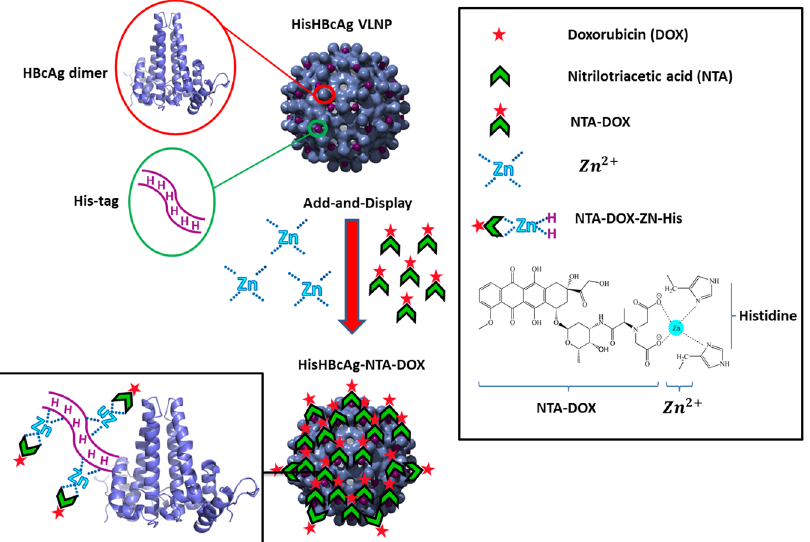
Figure 1. Schematic representation of the Add-and-Display method for immobilisation of doxorubicin non-covalently on His-tagged VLNPs. The HisHBcAg VLNP is made up of many copies of HBcAg dimers (blue). The His-tag fused at the N-terminal end of the HBcAg monomer forms trimeric spikes (magenta) and are exposed on the surface of the HisHBcAg VLNP. NTA-DOX is synthesised from nitrilotriacetic acid and doxorubicin hydrochloride. In the presence of Zn 2 + , the NTA-DOX interacts with histidine residues and is displayed on the surface of the